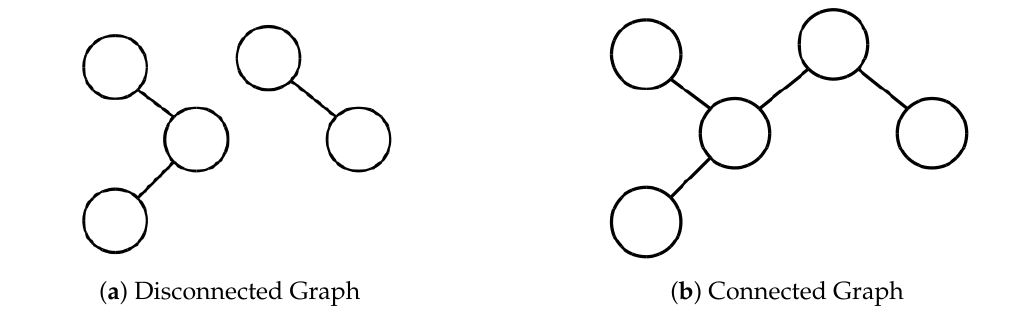
Figure 4. To determine whether stitching is possible, we need to check that there is sufficient overlap between the views. To do this, we create a graph where each node represents a camera and the existence of an edge specifies that there is enough overlap between the two cameras that stitching could